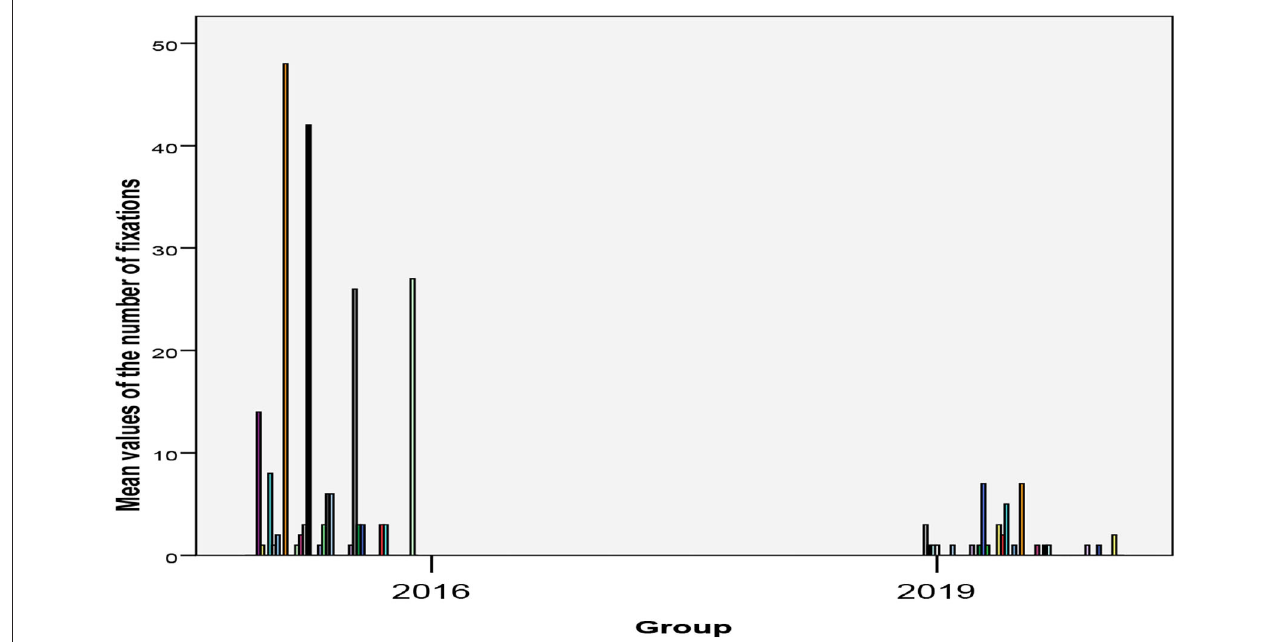
FIGURE 1 | Frequency of mechanical fixations per affected patient separated by